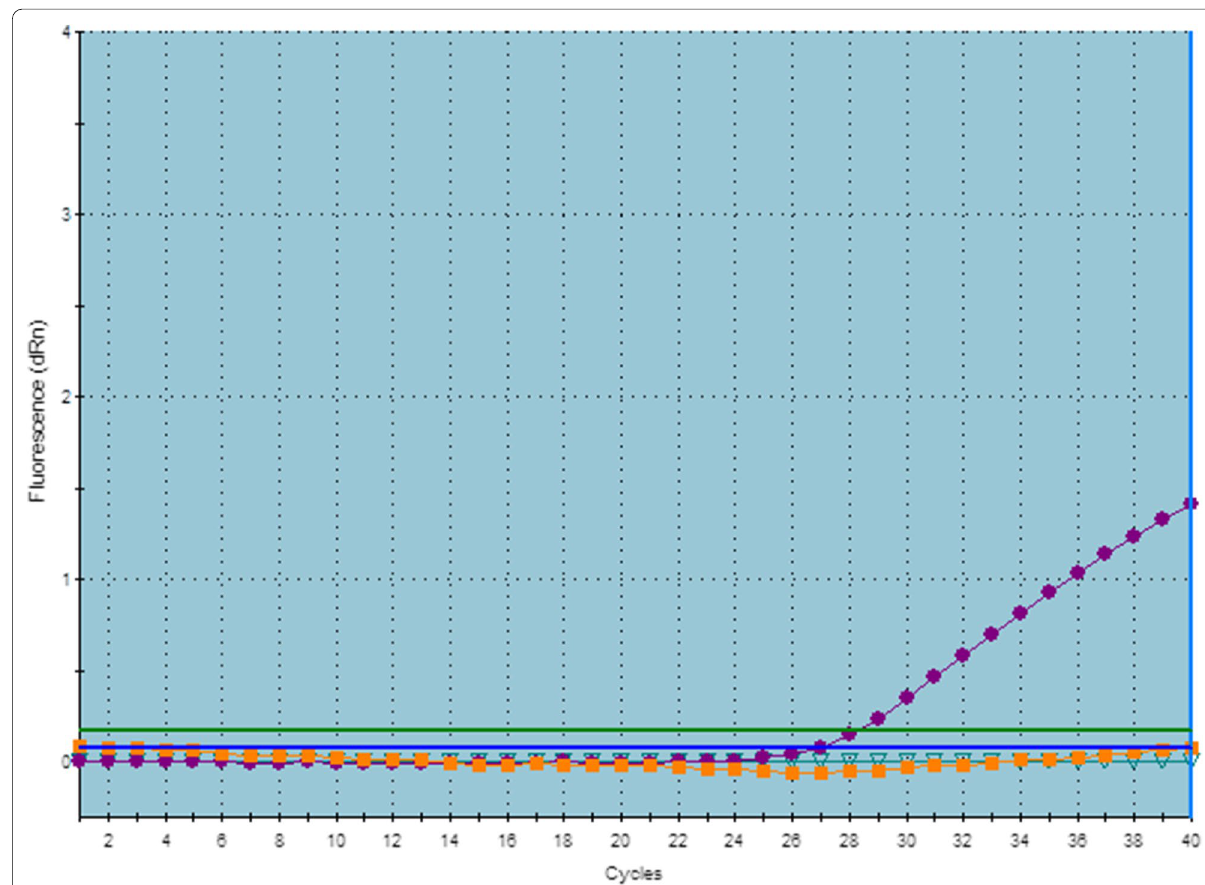
Fig. 2 Amplification plot curve showing a case with AA homozygous genotype for DVWA gene SNP ( rs11718863 ). It shows amplification of A allele with no amplification of T allele. A allele is represented as circles and T allele is represented as